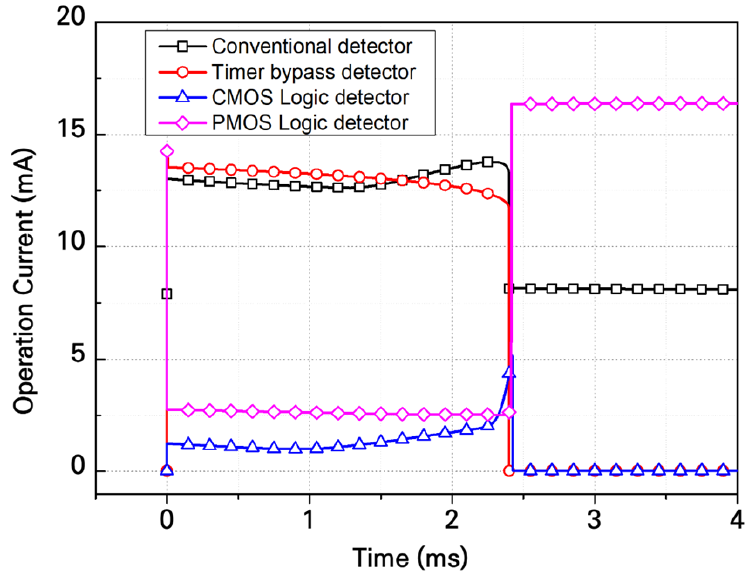
Figure 8. Operating current simulation result of the pulsed-radiation detection circuit (at pulse width, 2.3 ms).